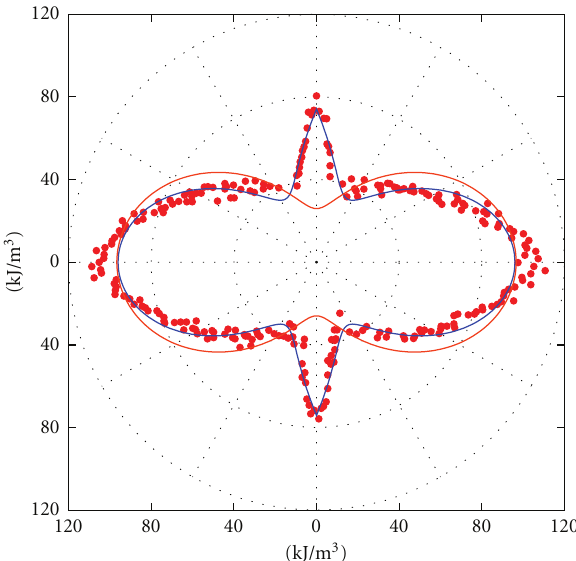
Figure 1: MAE for the sample 2.0 nm thick. In addition to the best fitted line (blue) shown is the “pure” uniaxial part (scaled) of anisotropy. Note the remarkable di ff erence between the two near ϕ = 90 ◦ and ϕ = 270 ◦ . 156 measurements.